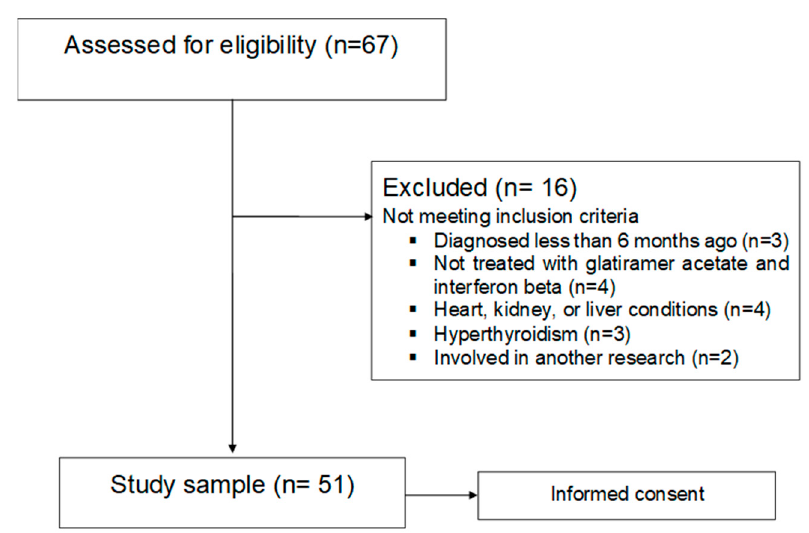
Figure 1. Enrollment flow diagram.